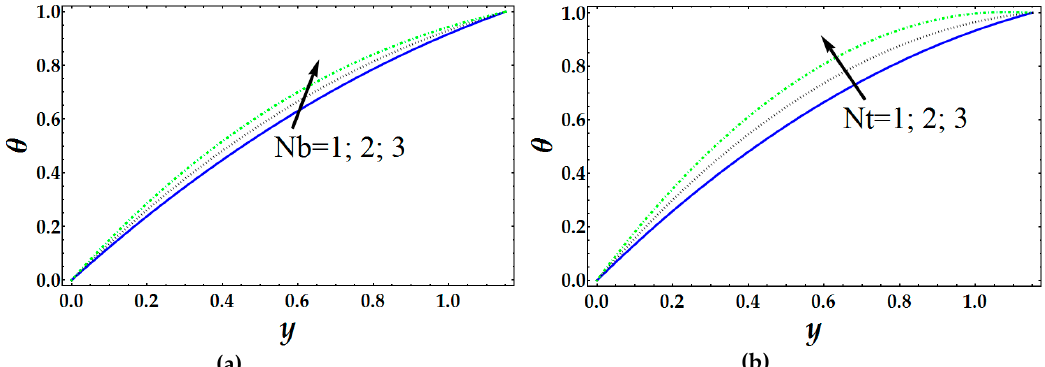
Figure 2. Temperature profile for various values of N b and N t .